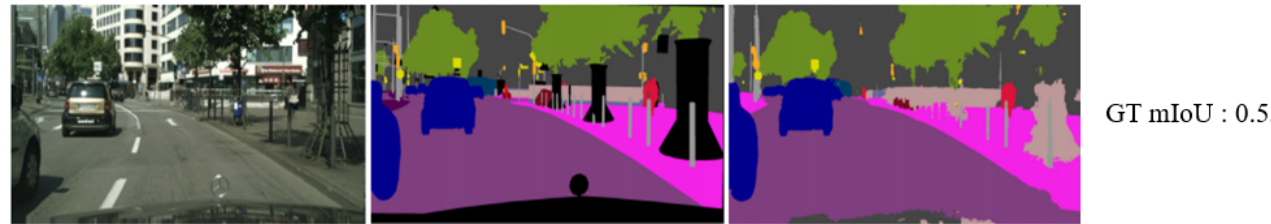
Figure 3. An example of an input image ( left ); ground-truth (GT) segmentation map ( middle ); and segmentation map ( right ).